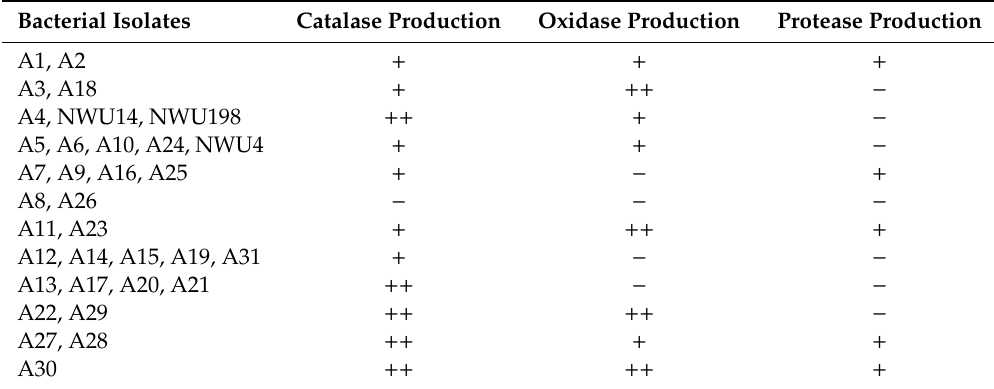
Table 2. Biochemical characterization of